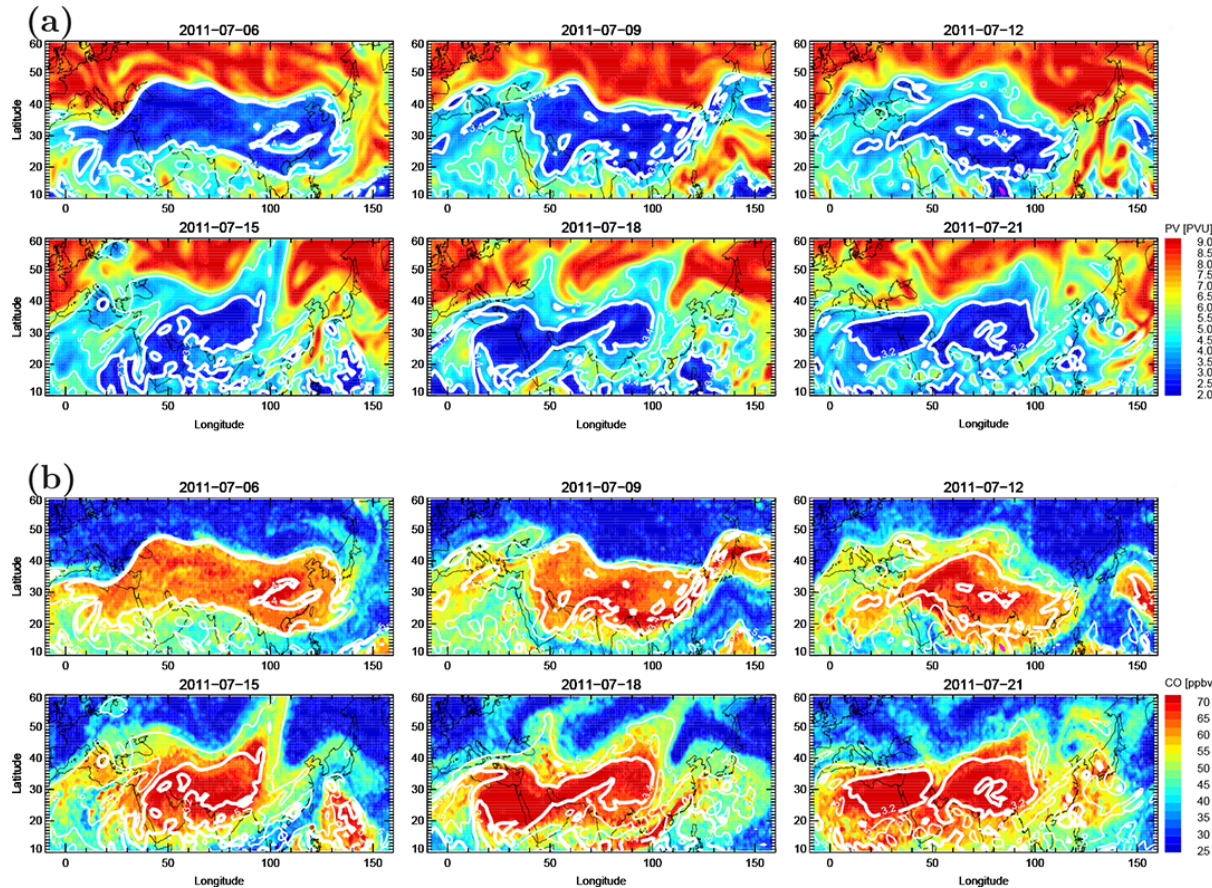
Figure 10. (a) Potential vorticity maps at 380K on 6, 9, 12, 15, 18, and 21 July 2011. The thick white contour shows the calculated anticyclone transport barrier (maximum PV gradient), the thin white contour 5PVU. (b) Maps of CO from CLaMS on the same days, with PV-based transport barrier included as white